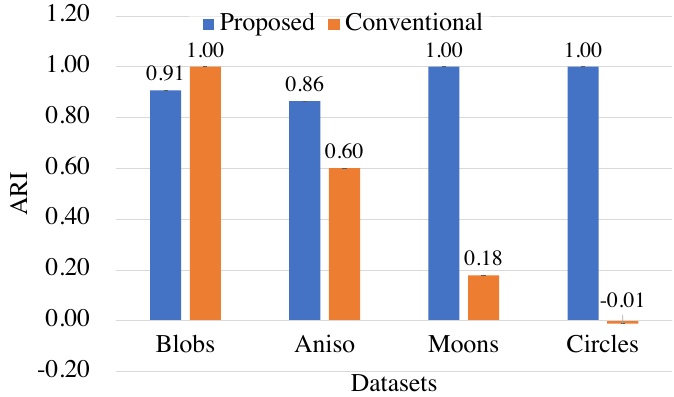
Figure 4. The qualities of the proposed kernel-based and conventional Euclidean-based methods for different